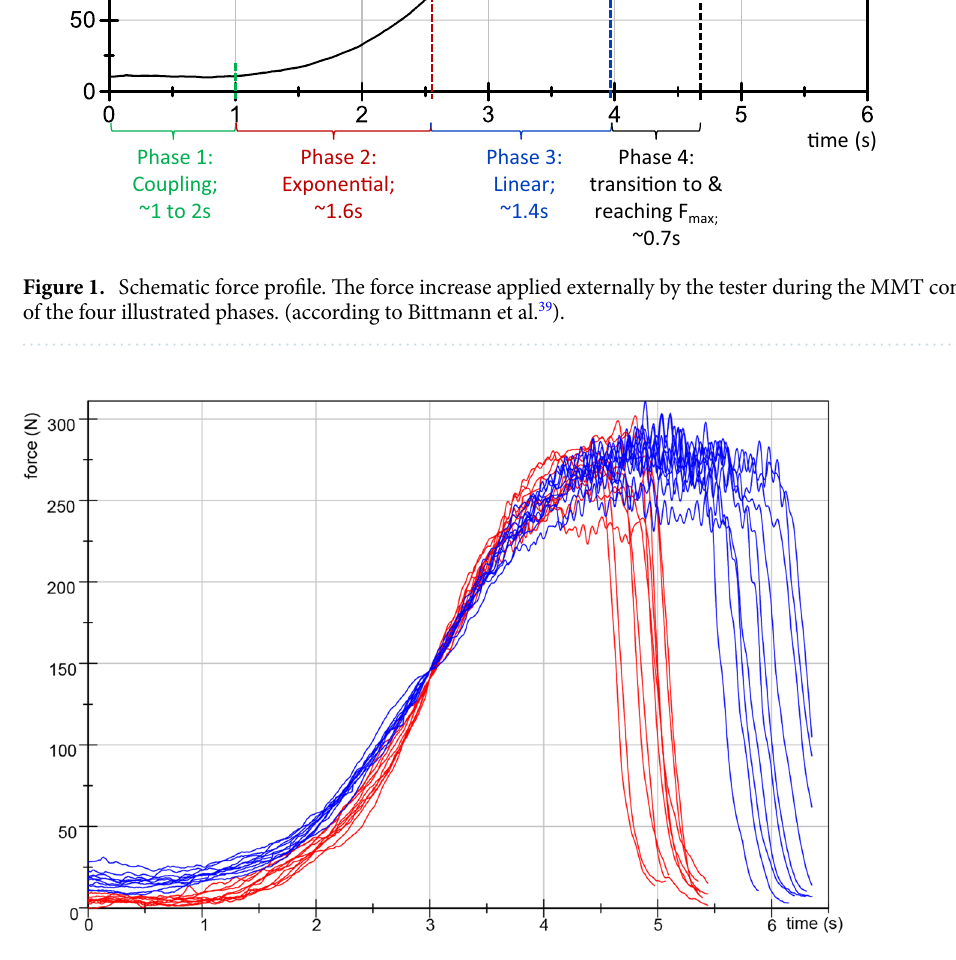
Figure 2. Repeated force profiles against a stable resistance. Ten repeated force profiles of tester 1 (female, red) and tester 2 (male, blue) against a stable resistance in the MMT setting of the hip flexors (filtered with Butterworth, cut-off frequency 20 Hz, filter degree 5). (according to Bittmann et al. 39